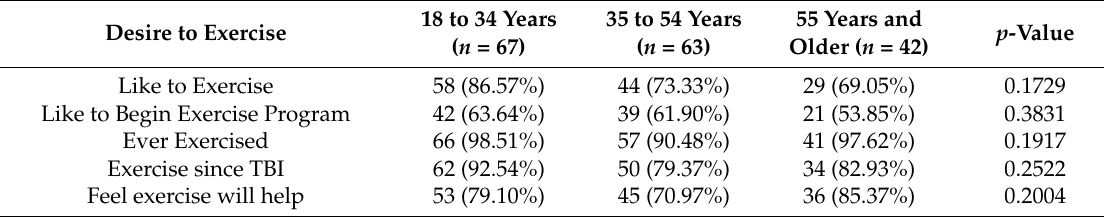
Table 2. Desire to exercise based on age